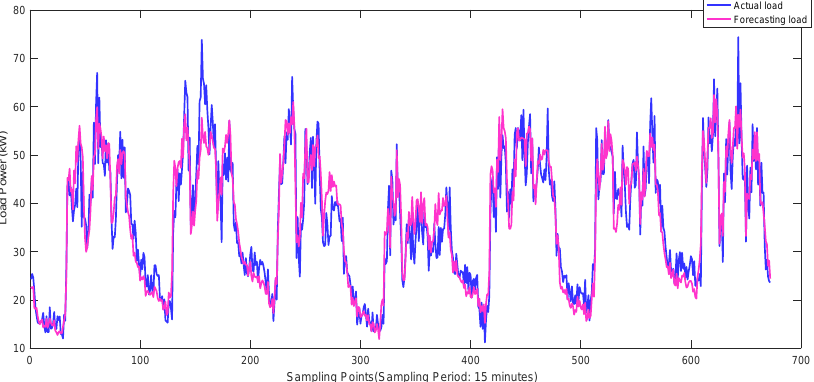
Figure 11. Compared curves of actual load and forecasting load in a week for Customer 53990001. The samples are preprocessed by K-means clustering algorithm to form three categories for training. We performed a comparative experiment with variable-controlling approach about clustering. The compared results of Customer 53990001 on four different days of November 2013 are shown in Figure 12. The compared MAPEs of prediction on 18 November for nine customers in three categories from different feeders are shown in Table 7. It can be concluded that the forecasting curve without clustering deviates from the actual curve and that its MAPE is larger. The reason is that